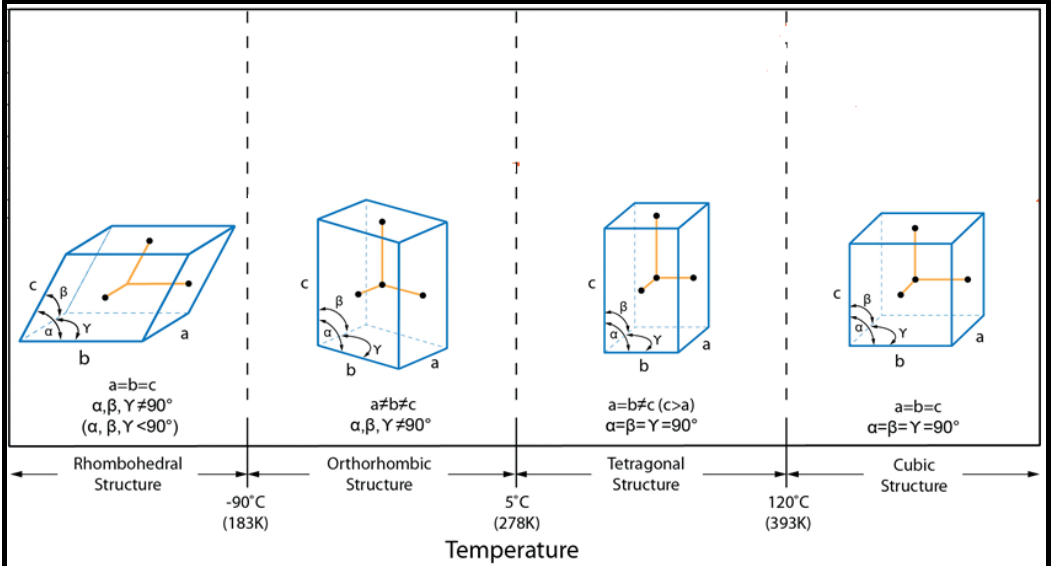
Fig. 2: Phase transformations of pure BaTiO